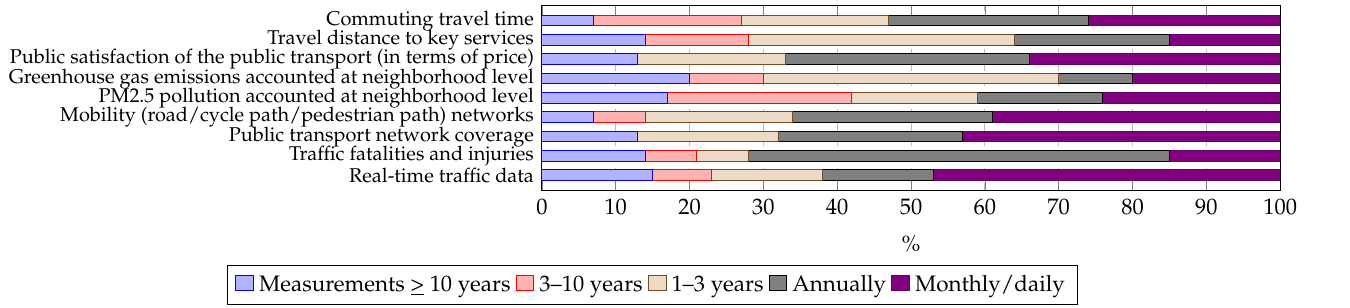
Figure A2. Data measurement frequency ( N = 23).